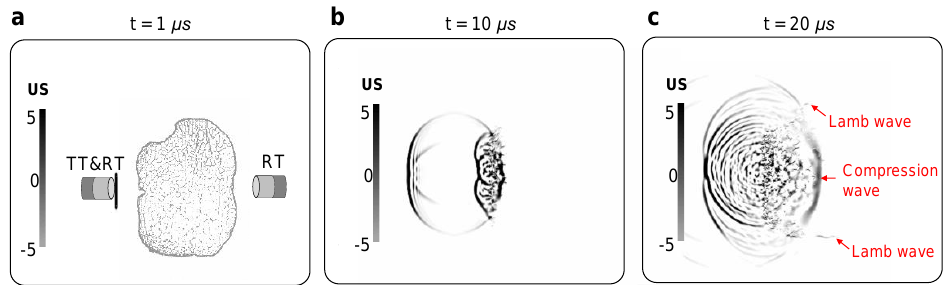
Figure 3. Ultrasound simulation results. ( a ) Simulation results at t = 1 µs in the US mode. ( b ) Simulation results at t = 10 µs in the US mode. ( c ) Simulation results at t = 20 µs in the US mode. TT, transmitting transducer; RT, receiving transducer.